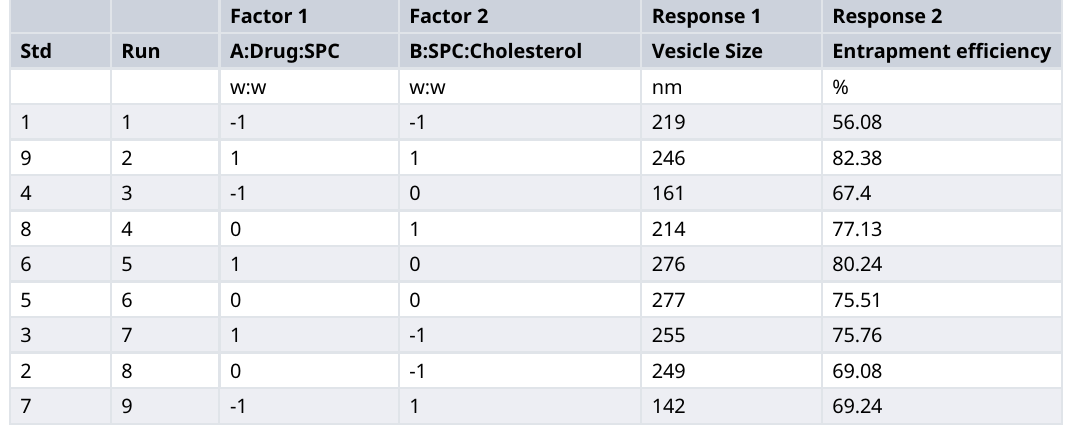
Table 2. 3 2 level factorial randomised quadratic design experimental trial batches, with obtained vesicle size (nm) and entrapment efficiency (%). Factor 1 Factor